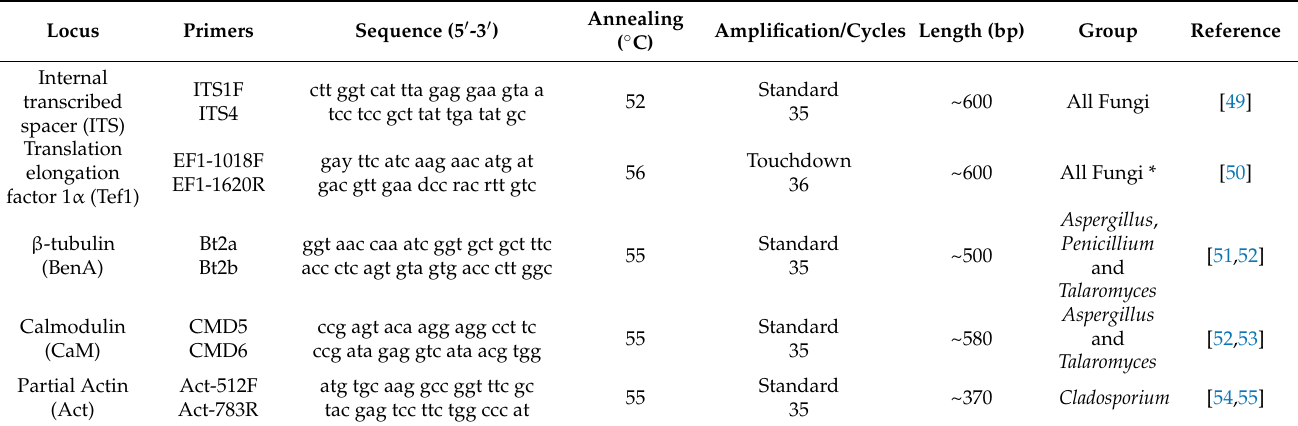
Table 1. Primers used for fungal isolates